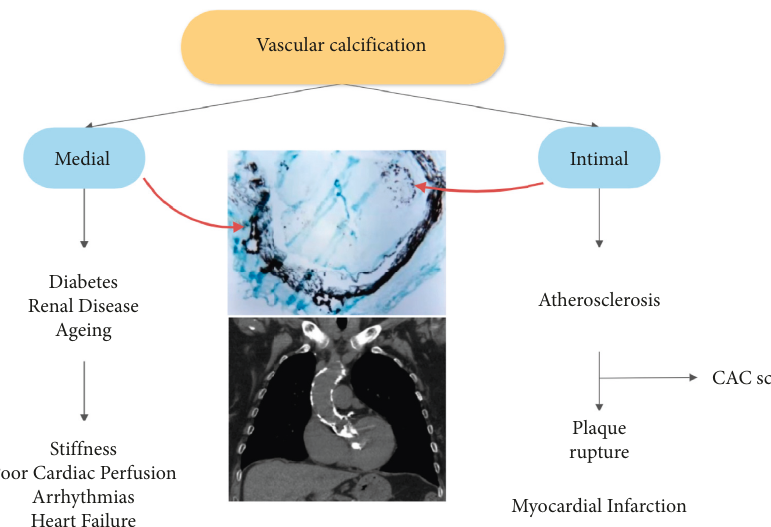
Figure 3: Site-specific phenotype of calcific lesions according to their location within the arterial